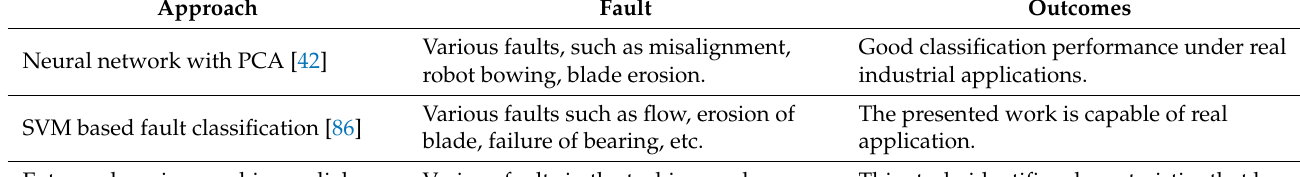
Table 2. Comparison of Data-Driven Based FDD Approaches for Steam TPP